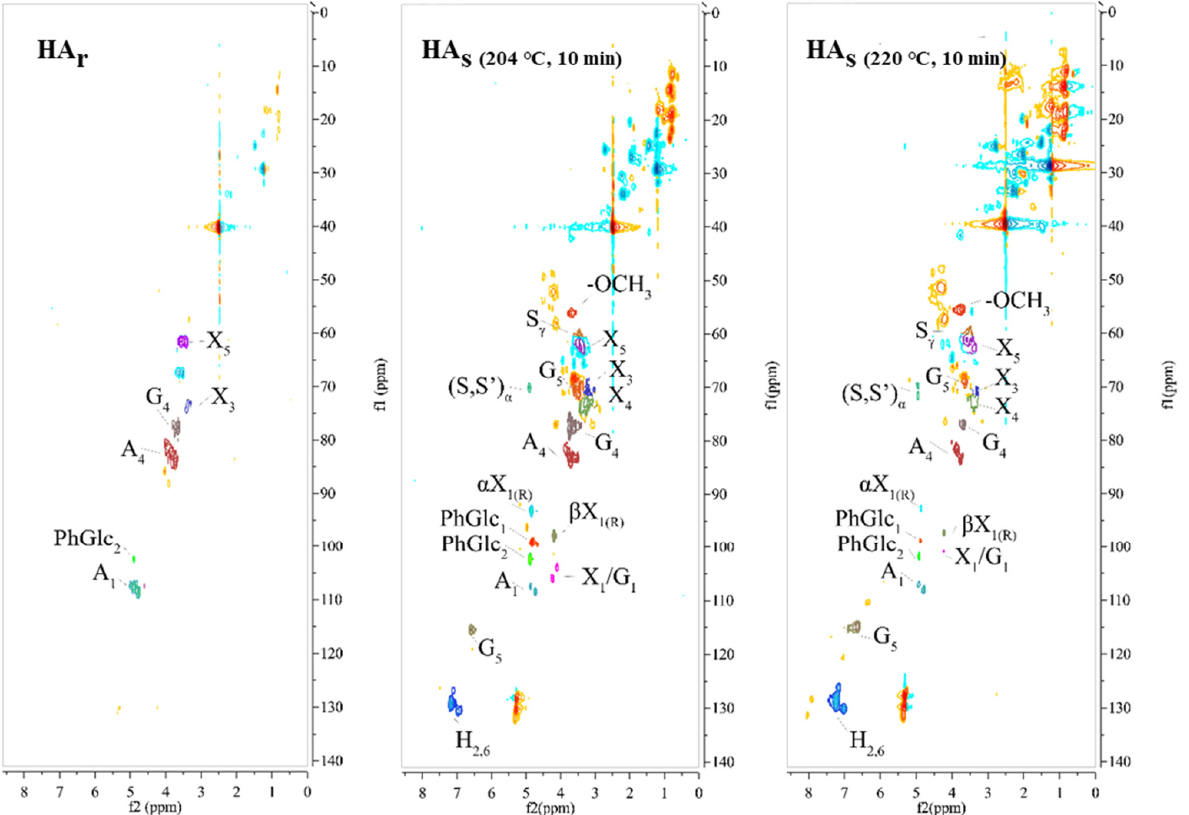
Figure 5. 2D HSQC-NMR spectra for HA s isolated from raw broccoli and SE broccoli.